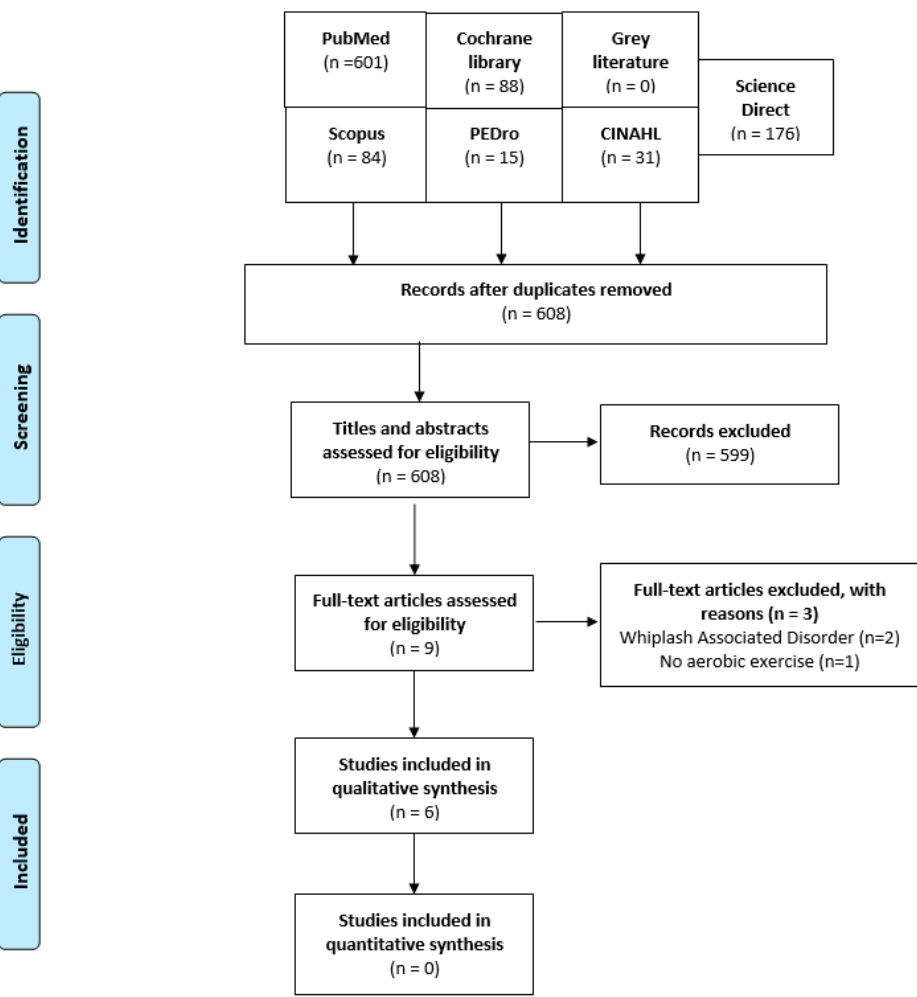
Figure 1. Preferred Reporting Items for Systematic Reviews and Meta-Analyses (PRISMA) flow diagram of the search results .